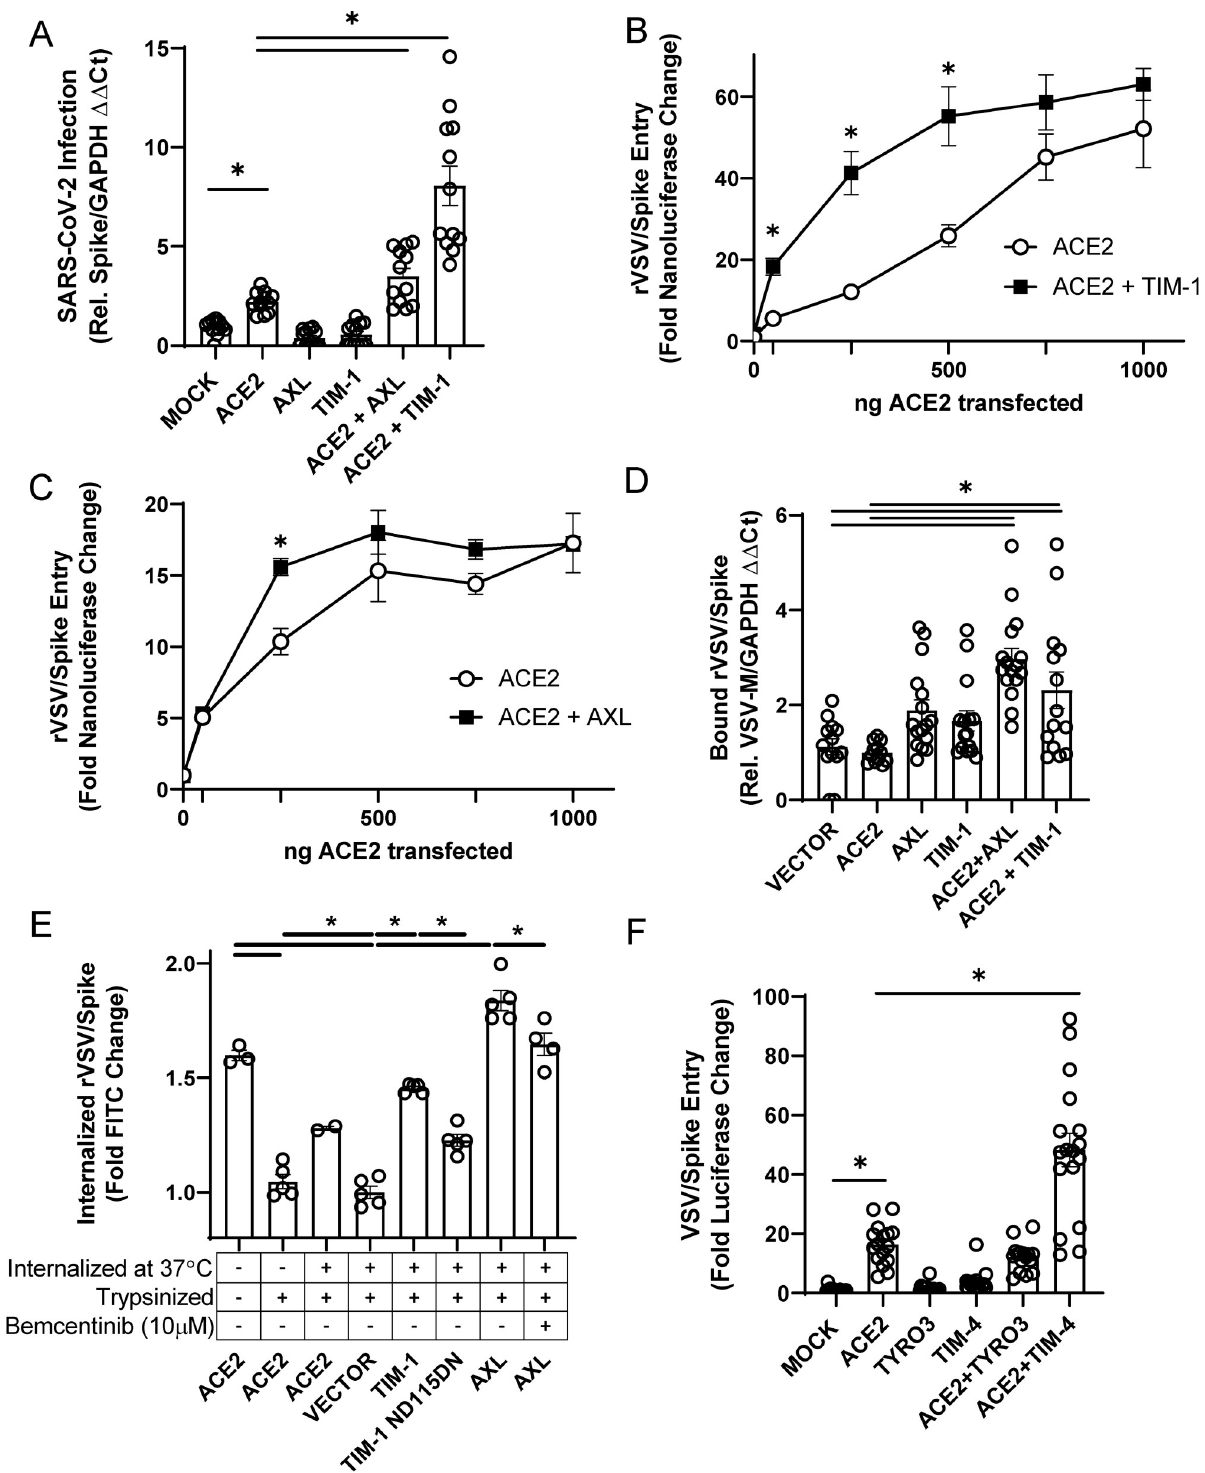
Fig 1. PS receptors synergize with ACE2, enhancing SARS-CoV-2 infection of HEK 293T cells. A) Cells transfected with PS receptor expression plasmids, AXL or TIM-1, with or without 50 ng of ACE2 and infected 48 hours later with SARS-CoV-2 (MOI = 0.5). Resulting cellular infection was determined by viral loads 24 hours after initial infection using RT-qPCR. B-C) PS receptors, TIM-1 (B) and AXL (C) , enhance rVSV/Spike infection at low concentrations of transfected ACE2. D) Virus binding of cells transfected with PS receptor plasmids with or without 50 ng of ACE2. rVSV/Spike